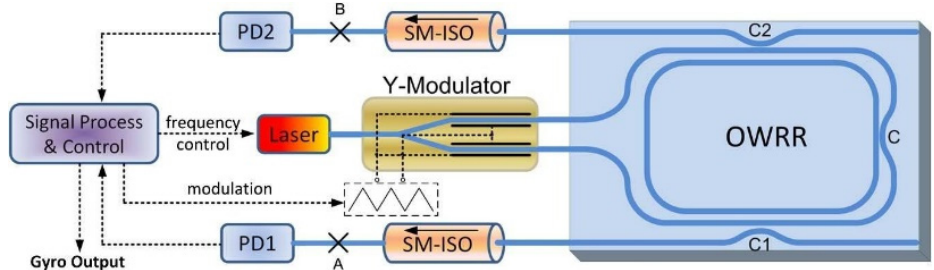
Figure 8. Sketch map of a RIOG system. SM-ISO: single-mode isolator; solid line, optical circuit; dash line, electric circuit. Reprinted with permission from ref. [26]. Copyright 2013 The Optical Society.